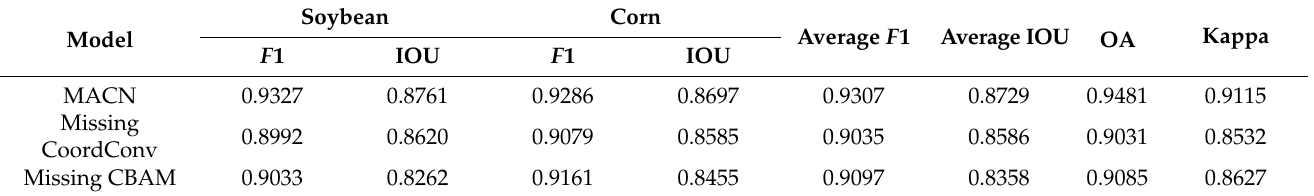
Table 5. Accuracy of crop classification for MACN, Missing CoordConv and Missing CBAM.